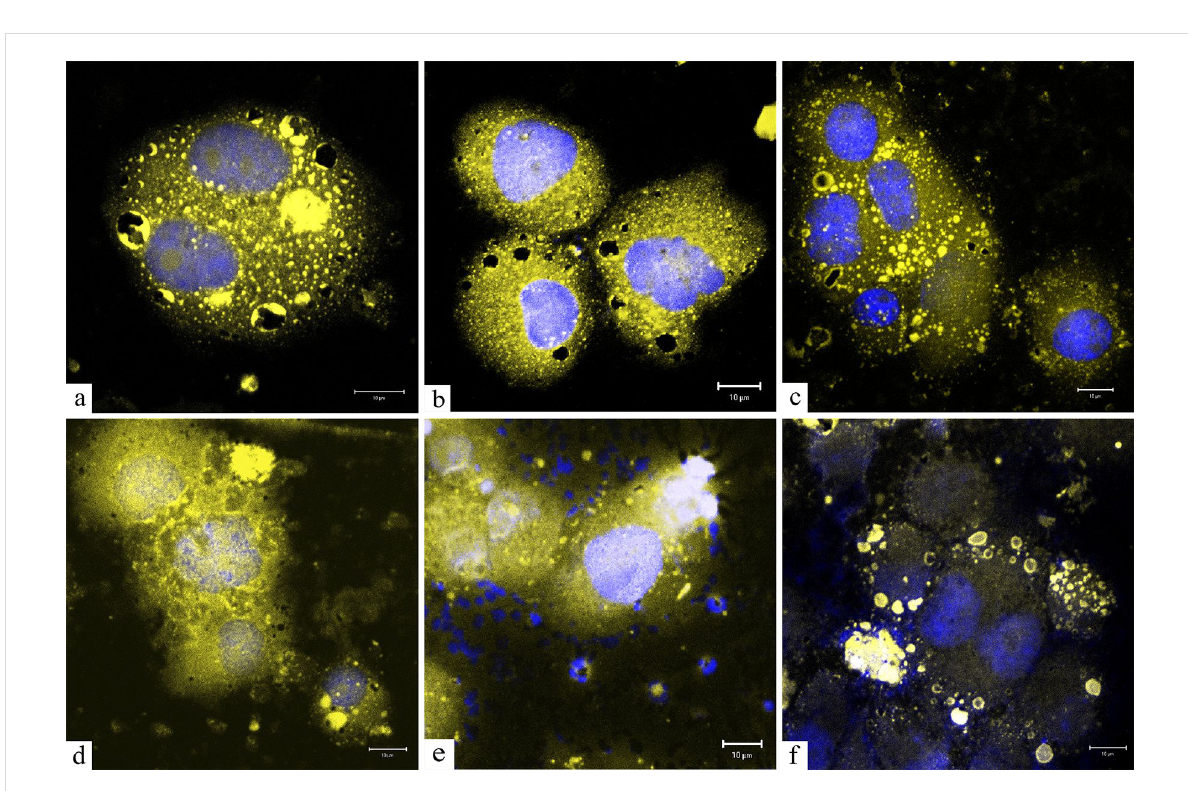
Figure 3: Confocal micrographs of 4BL human stem cells treated with (a, b) D-mannose-coated γ -Fe 2 O 3 , (c, d) PDMAAm-coated γ -Fe 2 O 3 and (e, f) non-coated γ -Fe 2 O 3 nanoparticles. Staining with DAPI and ThR. Scale bars: 10 μ